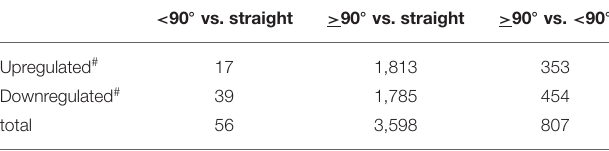
TABLE 2 | Differentially expressed genes amongst the three necking stages. < 90 ◦ vs.